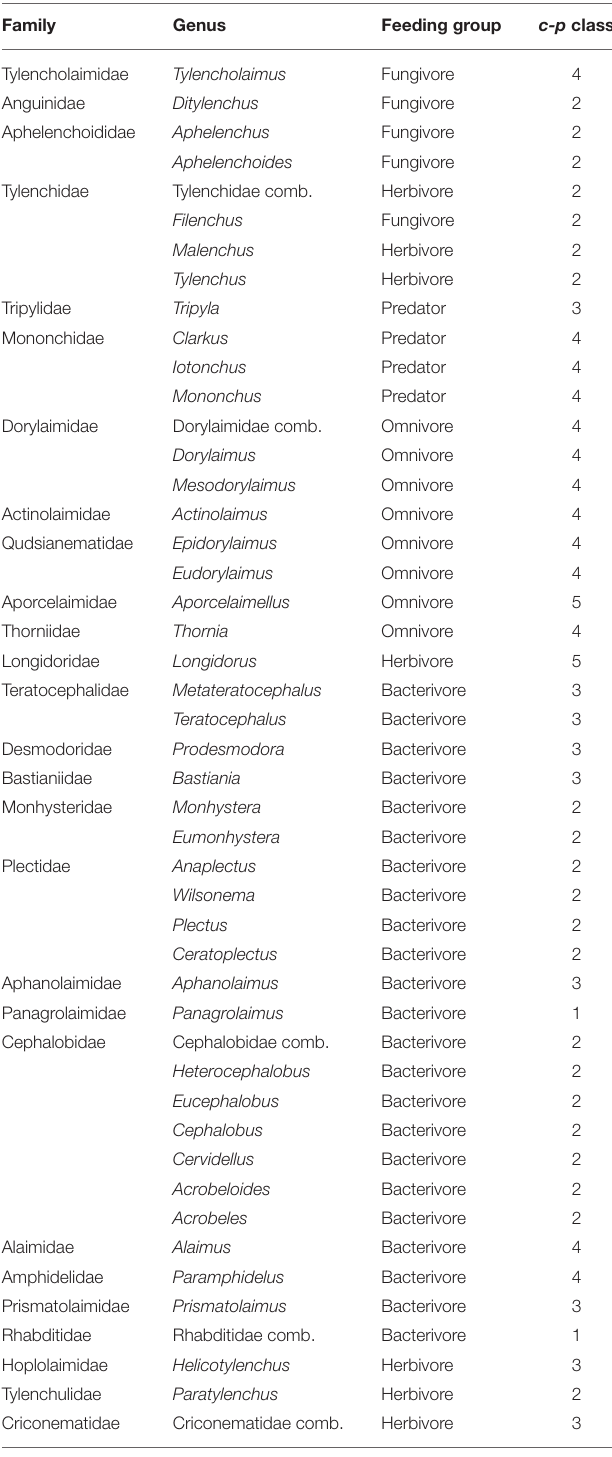
TABLE 1 | Information on trophic group and c-p class for each